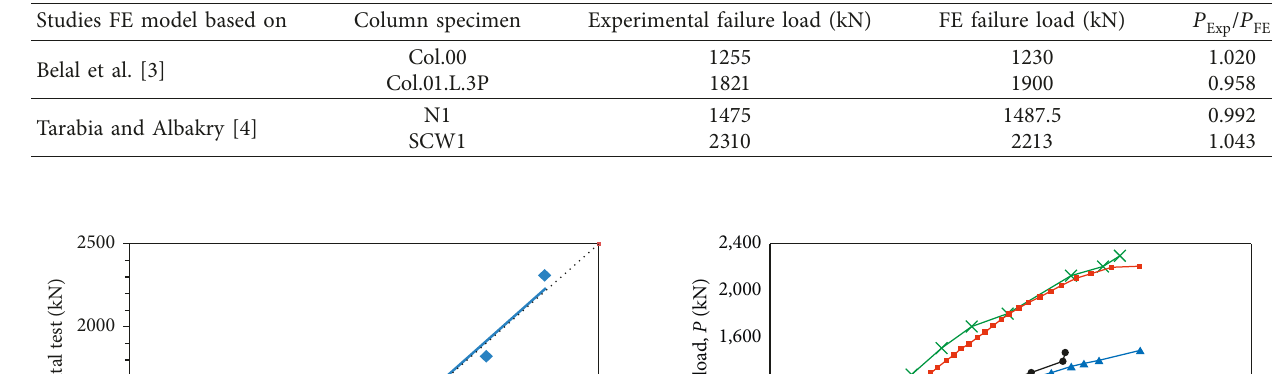
Table 3: Comparison of failure load and ratios of P